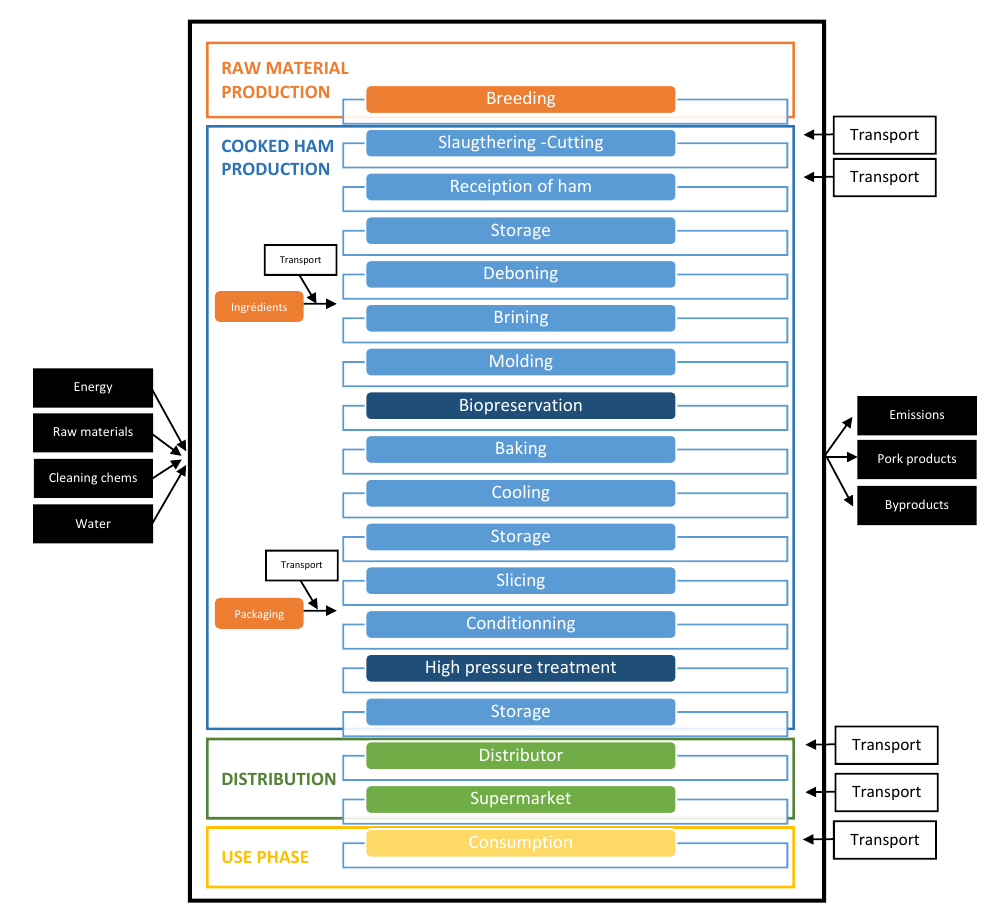
Figure 2. Cooked ham life cycle (brown for raw material, blue for cooked ham production, green for distribution, and orange for